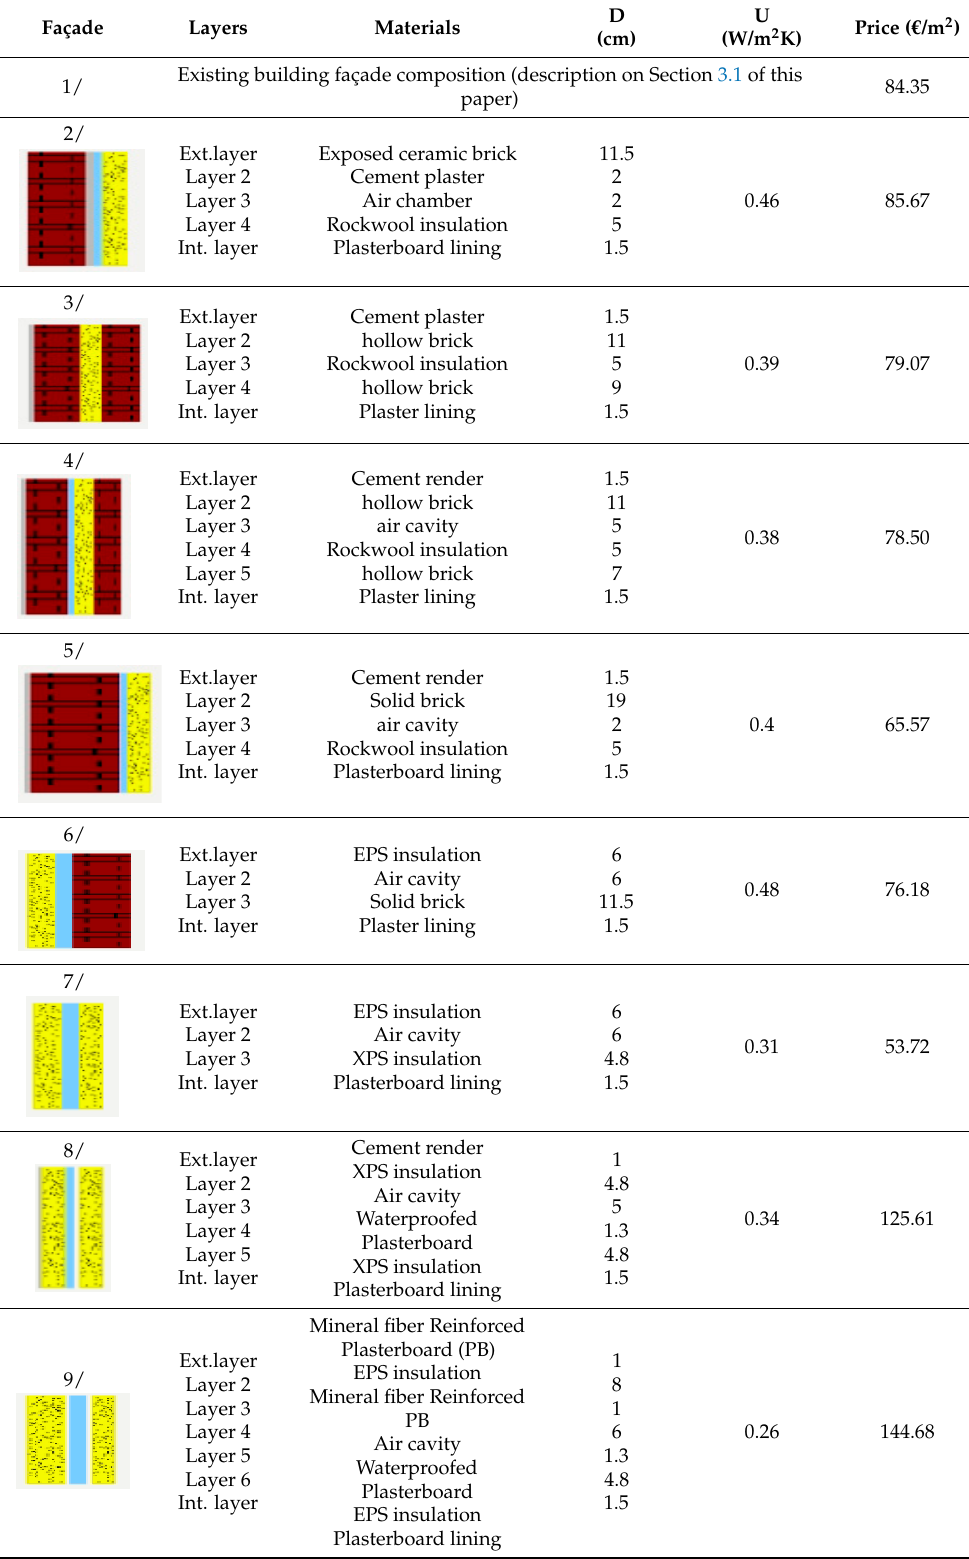
Table A2. Proposed Façade renovation measures.